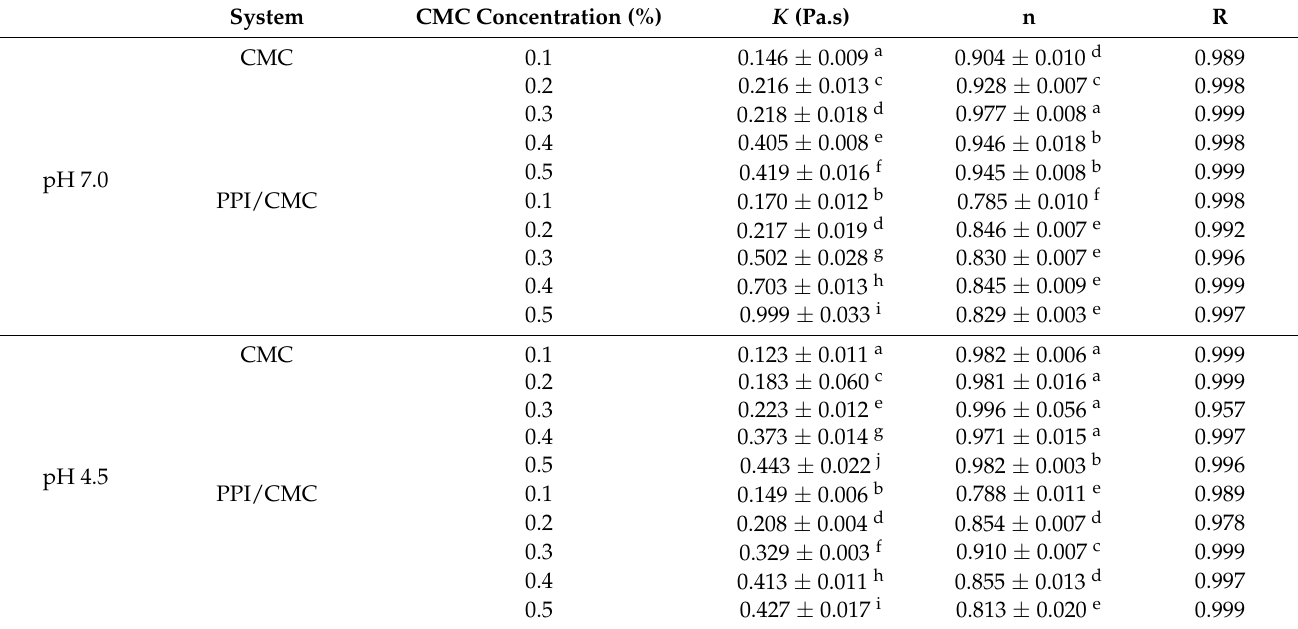
Table 1. K and n values for CMC and PPI/CMC mixed solutions at pH 7.0 and